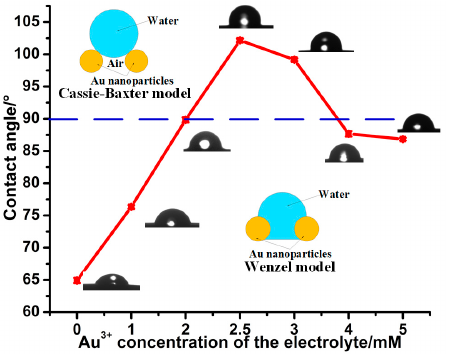
Figure 7. E ff ect of the Au 3+ concentration of the electrolyte on the CA values of Au solid contact layers.